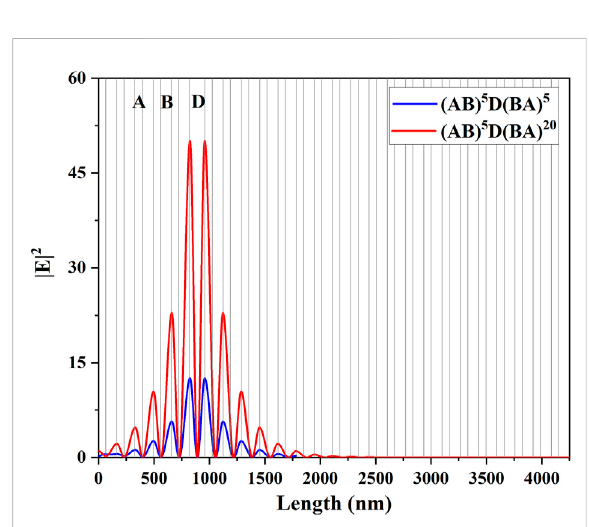
FIGURE 3 Simulated intensities of the electric fi eld at the resonant wavelength ofthePC(AB) M D(BA) N .Blueandredlinesdescribe(AB) 5 D(BA) 5 at the wavelength 570.65 nm and (AB) 5 D(BA) 20 at the wavelength 570.58 nm, respectively. All parameters are the same as those used in Figure 2A and